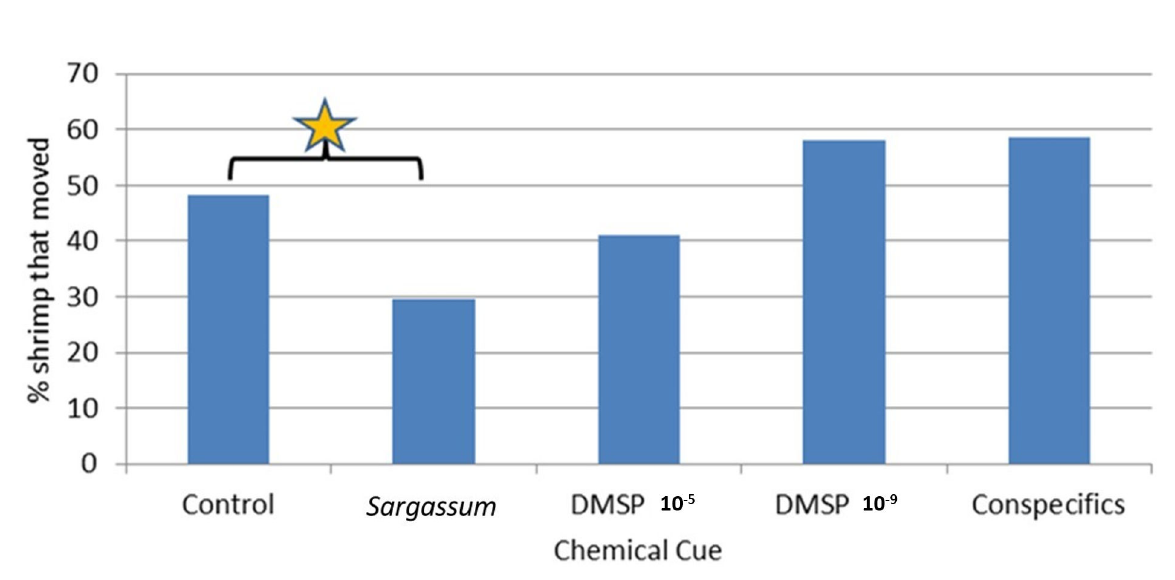
Figure 5. Number of Leander tenuicornis shrimp that moved out of area C in the Y-maze for the control, Sargassum , DMSP 10 − 5 M, and conspecific cue trials (binomial test; Sargassum , p = 0.03; DMSP, p = 0.08; and conspecifics, p = 0.01). Star/bracket indicates significant differences between indicated paired groups.